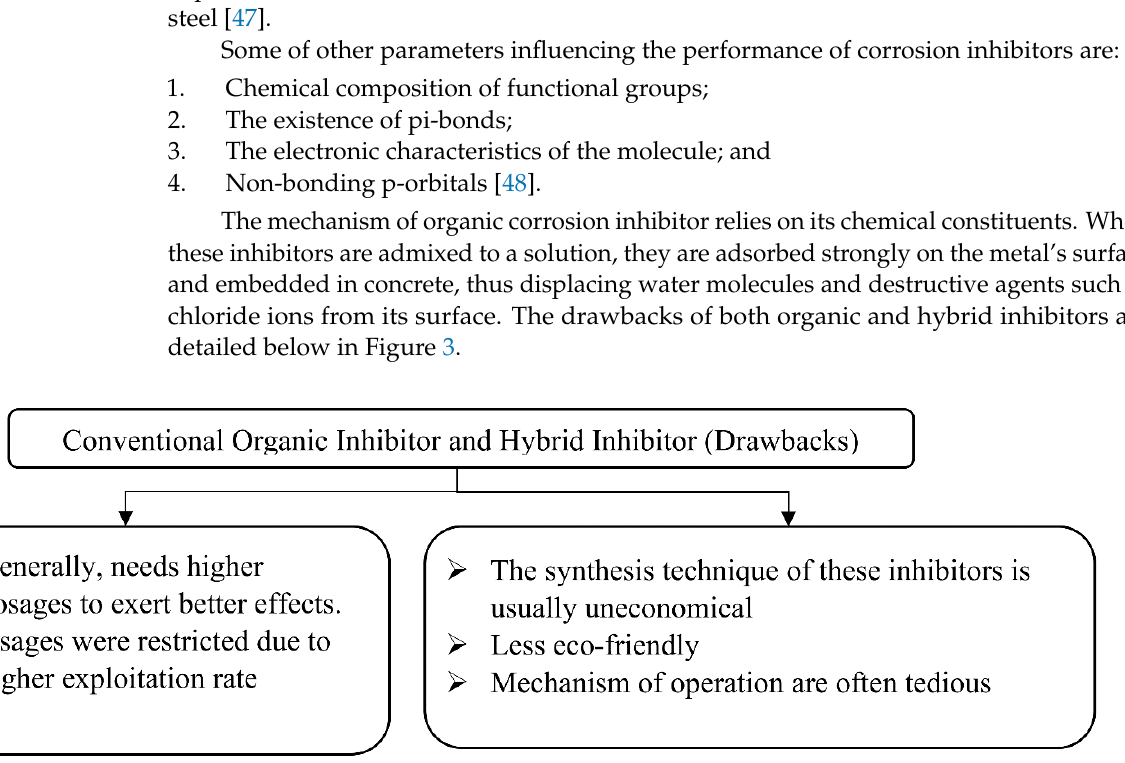
Figure 3. Drawbacks of Conventional Organic Inhibitor and Hybrid